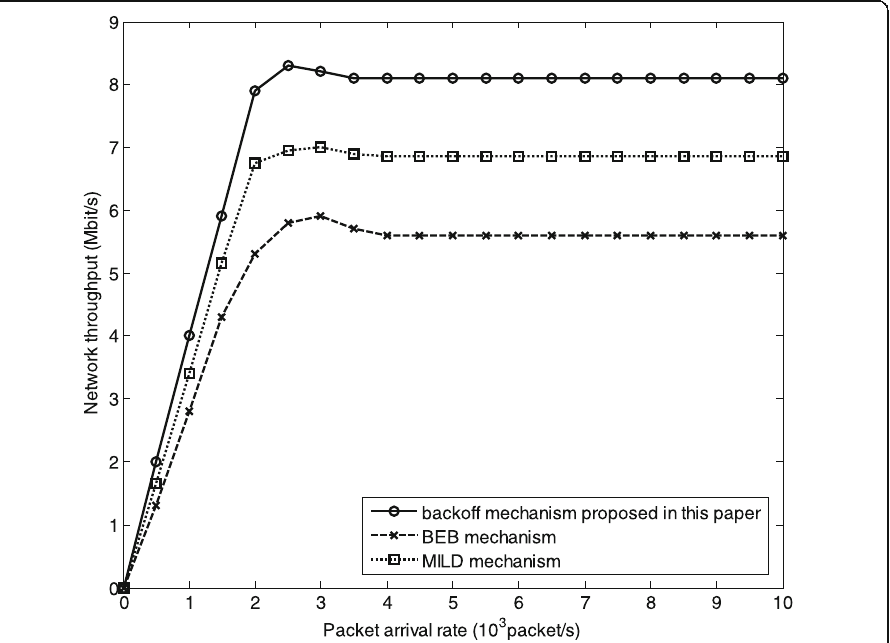
Fig. 9 Network throughput in different backoff mechanisms with different packet arrival